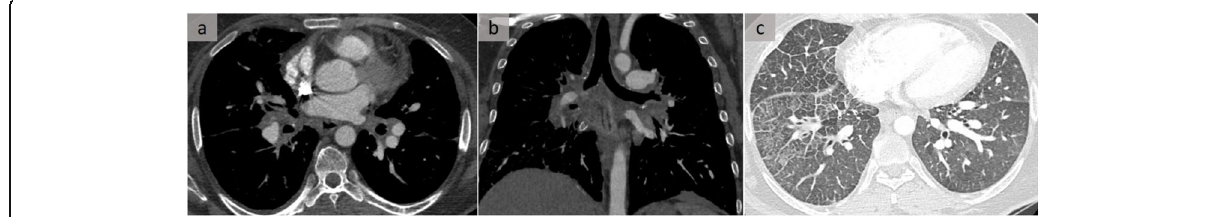
Fig. 10 Post-tuberculous mediastinitis. A patient with chronic mediastinitis related to sequelae after tuberculosis. Axial ( a ) and coronal ( b ) CT in mediastinal windows show infiltration of the mediastinum and hila, which led to narrowing of the pulmonary veins on the right side. CT scan at the level of the heart in pulmonary windows shows right-sided septal-line thickening linked to impaired venous return (thanks to Prof. Halimi, Georges Pompidou Hospital, France)